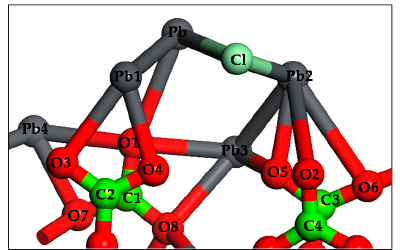
Figure 6. Adsorption configurations of PbCl + on perfect cerussite (110) surface.